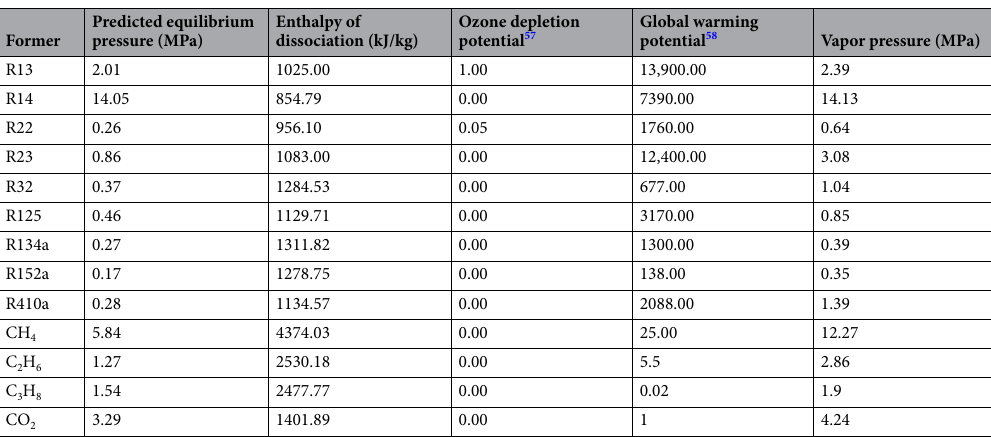
Table 8. Refrigerant hydrate equilibrium and dissociation enthalpies estimated at 281